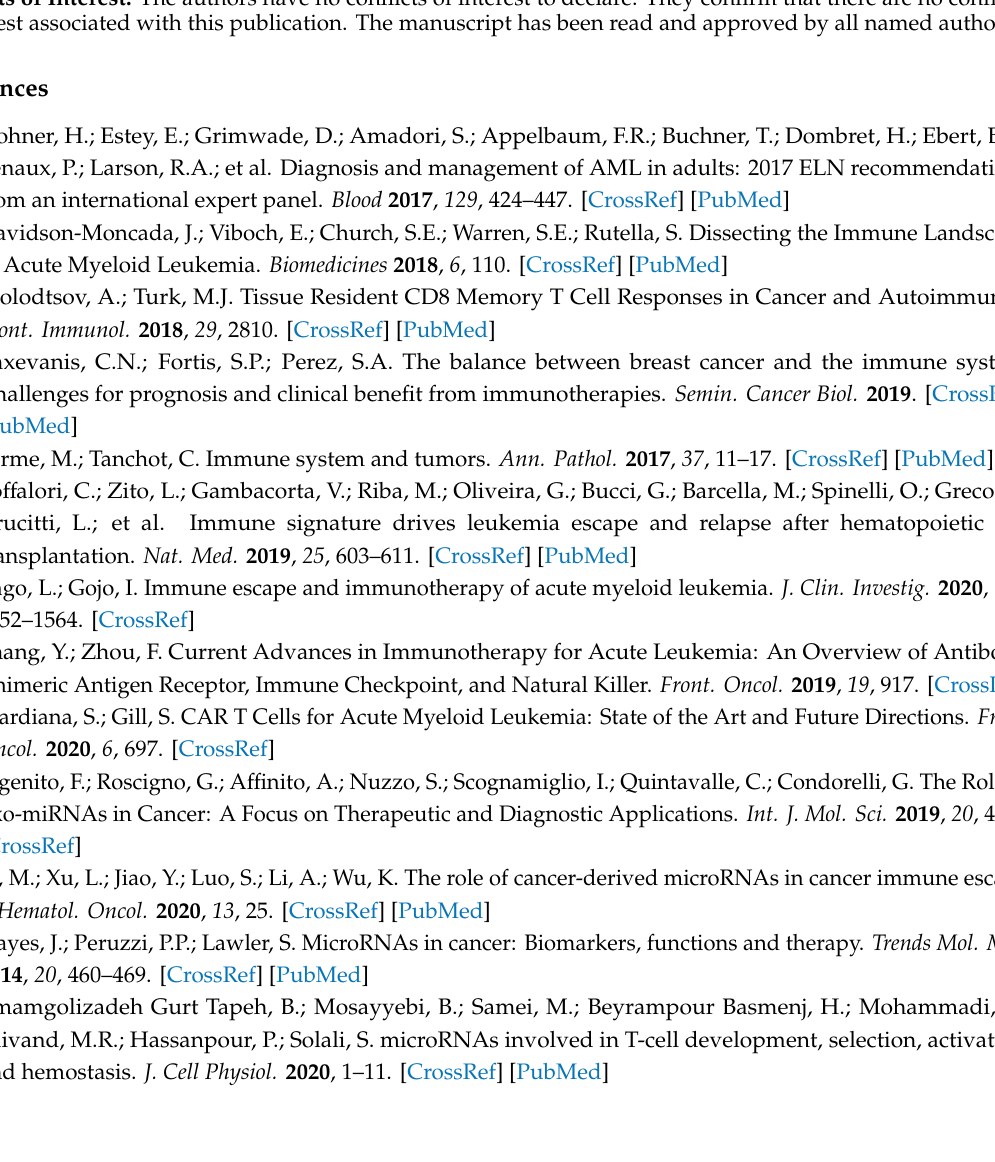
Table S1: miR-21 expression profile in the